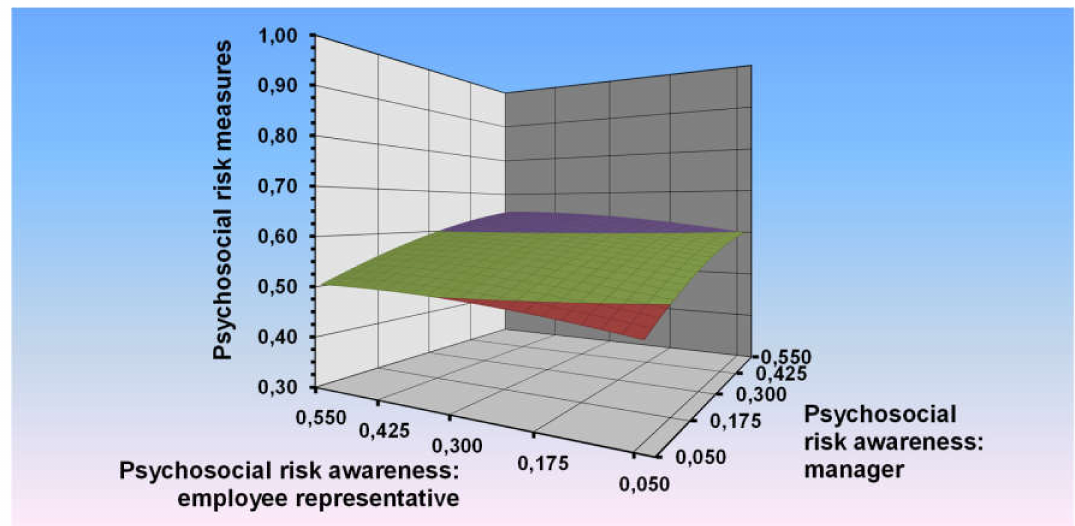
Figure 1. Psychosocial risk measures explained by the combination of the psychosocial risk perception and awareness of the manager and the employee